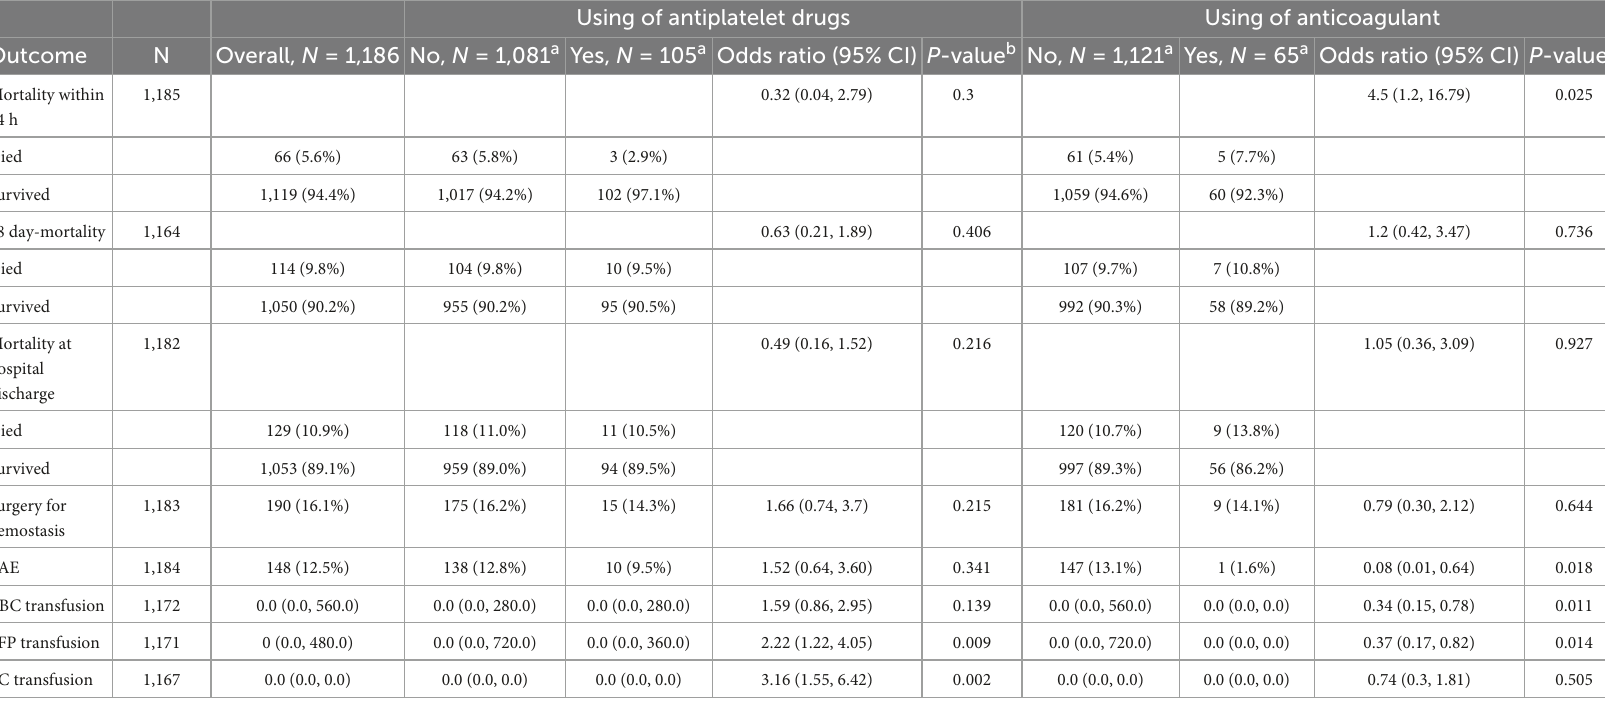
TABLE 2 Multivariable binary/proportional odds logistic analysis. Using of antiplatelet drugs Using of